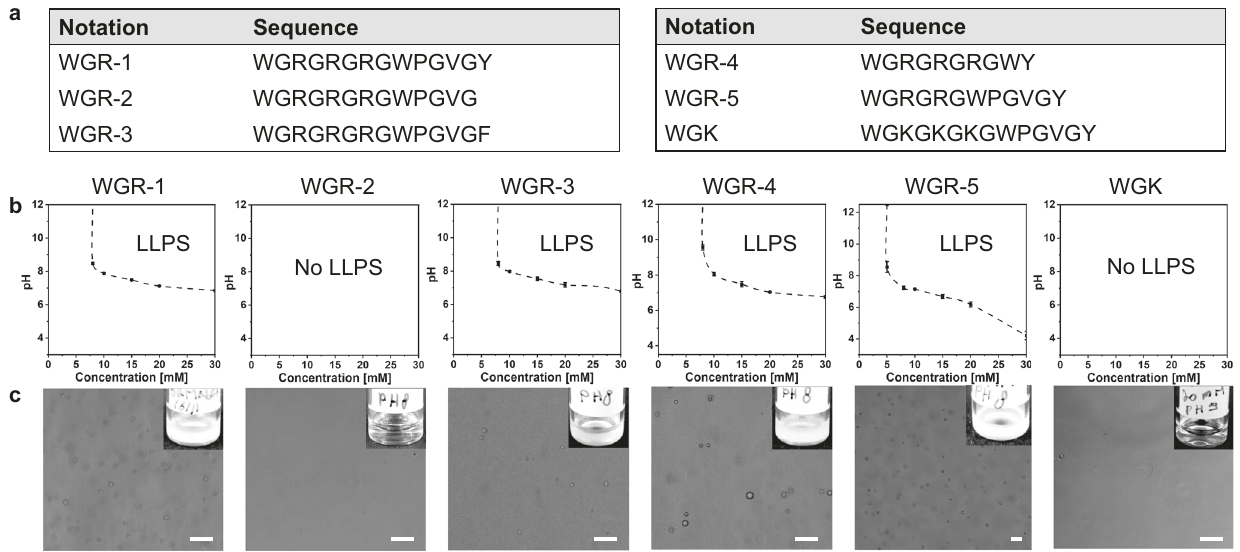
c Confocal microscopy bright fi eld images of peptide liquid droplets formed at a concentration of 20mM inTrisbuffer at pH8 with0.2M NaCl.Scale bars=20 μ m. Inset: macroscopic images of the peptide solutions. ‘ Source data are provided as a Source Data fi